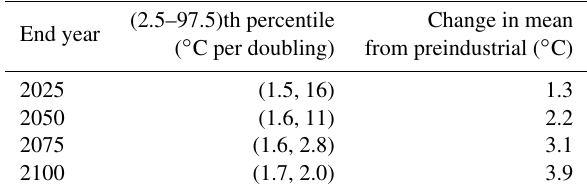
Table 2. Evaluation of how uncertainty in the sensitivity parameter, λ A , decreases as more data are observed, from simulations under the RCP8.5 scenario of future radiative forcing with an assumed value of λ A = 1 . 8 ◦ C per doubling. The middle column shows the (2.5– 97.5)th percentile intervals for λ A from simulations under the fitted model (4) and ARMA(4,1) noise. The rightmost column shows the increase in mean temperatures from the preindustrial climate under the fitted model at the year in question. Uncertainties in the upper bound of λ A decrease relatively slowly as more data are